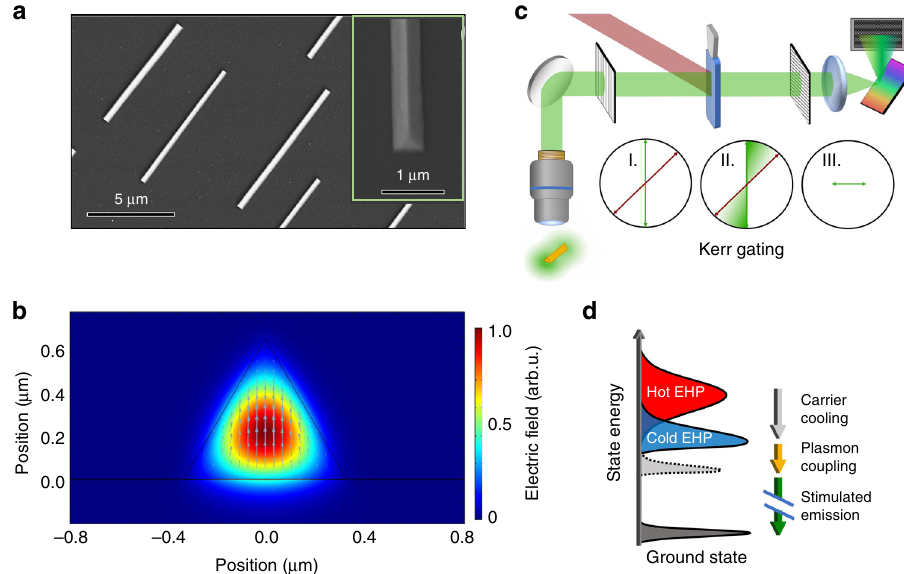
Fig. 1 Nanowire samples, experimental setup, and lasing mechanism. a Scanning electron microscopy images of triangular nanowires grown on sapphire substrate. b FEM simulation of the lowest order waveguiding mode in a nanowire. The electric fi eld polarization is depicted by the cyan arrows. c Illustration of the optical setup for time-resolved Kerr gating experiment. A microscope is used for excitation of the nanowire and collection of the lasing emission. The linear polarization (I) becomes elliptical (II) as it passes through the Kerr medium with the pump pulse. A fi nal polarizer (III) fi lters polarization perpendicular to the original incident polarization. d Cartoon describing the carrier dynamics from photoexcitation which results in a hot electron hole plasma (Hot EHP) through carrier cooling to a cold electron hole plasma (Cold EHP) fi nishing with stimulated emission coupled with plasmon